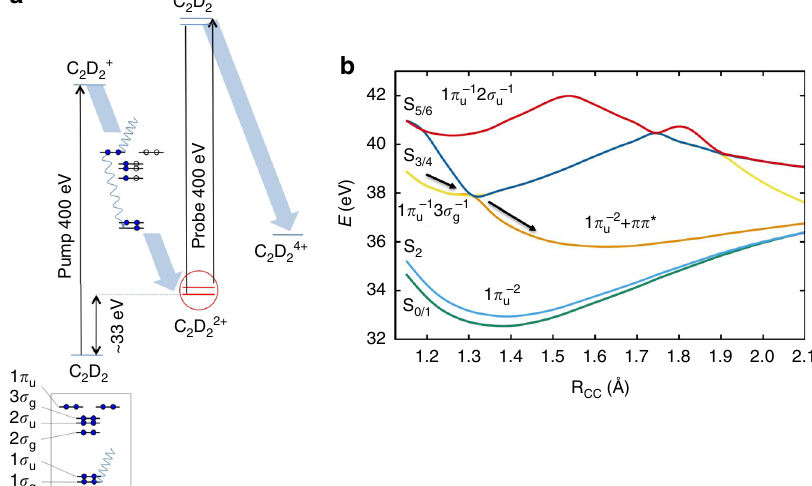
Fig. 1 Illustration of relevant dynamical processes after core ionization of acetylene. a Sketch of the acetylene dication dynamics induced by X-ray photoionization and Auger decay. A fi rst X-ray pump pulse core ionizes the neutral molecule to create the cation, which then undergoes Auger decay. A second X-ray probe pulse with a variable delay further core ionizes the dication, which promptly undergoes further Auger decay and Coulomb explosion. The momentum of the resulting fragments is measured to create the momentum map described in the text. b The potential curves of the singlet dicationic states are plotted in the adiabatic representation. The fi rst 3 adiabatic states S 0 – S 2 are dominated by a double hole con fi guration 1 π (cid:1) 2 S 3 and S 4 states have the double hole con fi guration 1 π (cid:1) 1 fragmentation pathway on S 3/4 , arising from a crossing of the diabatic states 1